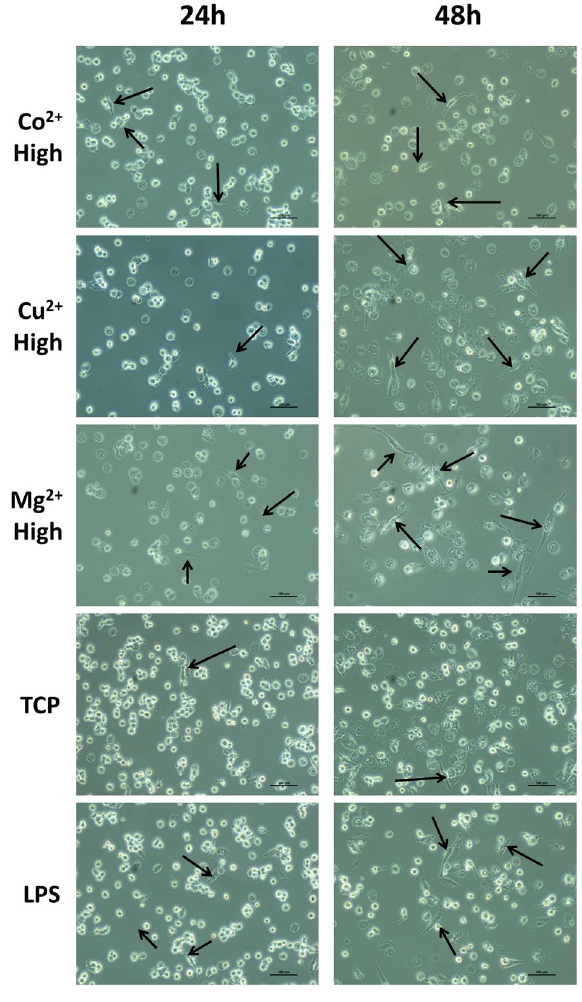
Figure 4. Effect of high concentrations of cobalt, copper and magnesium ions on THP-1 cell morphology. Elongated cells, which were defined as those in which the aspect ratio was higher than 2.5, are indicated with black arrows. Scale bars = 100